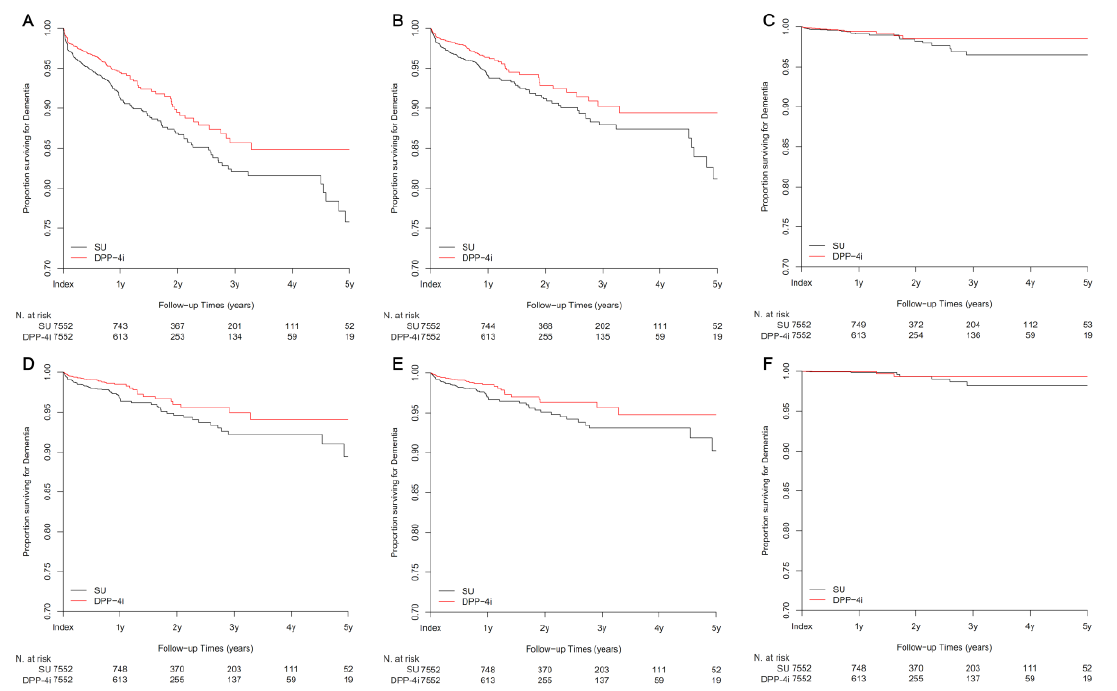
Figure 2. Kaplan-Meier plots for dementia-free survival in new users of DPP-4i and SU. ( A – C ) Dementia was defined by diagnosis codes; all-cause dementia ( A ), Alzheimer’s disease ( B ), vascular dementia ( C ). ( D–F ) Dementia was defined by both diagnosis codes and medications; all-cause dementia ( D ), Alzheimer’s disease ( E ), and vascular dementia ( F ). DPP-4i, dipeptidyl peptidase-4 inhibitor; N , number of patients; SU, sulfonylurea; y, year(s). Table 2. The risk of dementia in DPP-4i use compared with SU use.